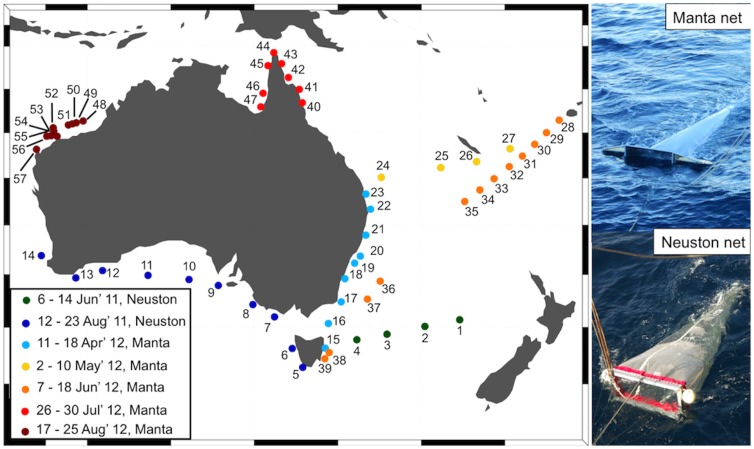
Location of the 57 net stations sampled during this study.Dot colors indicate the voyage when the net station was sampled and numbers follow the chronological order of sampling. Pictures of the two types of net used are shown in the right panel.